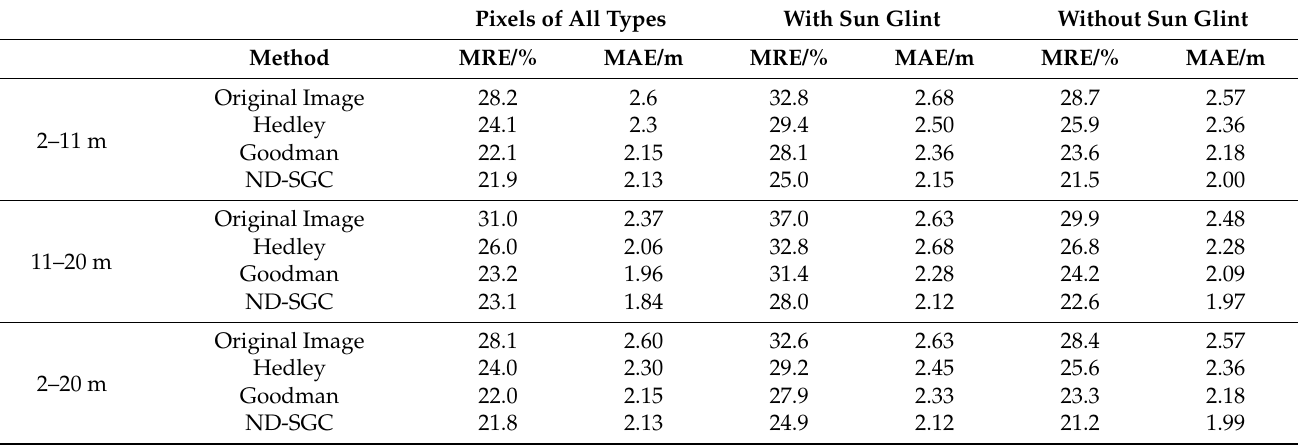
Table 5. Evaluation of bathymetric inversion accuracy of the Stumpf model for Sentinel-2 image